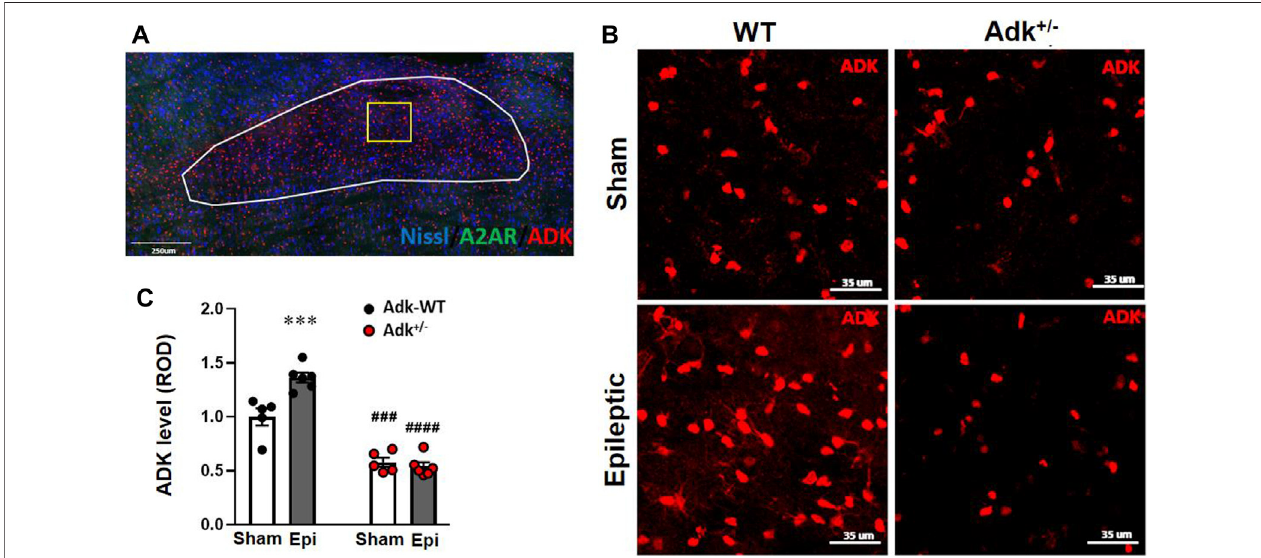
FIGURE 2 | ADK changes in the NTS of IHKA modeled epileptic mice. (A) Representative immuno fl uorescence (IF) image and an indication of selection of NTS region. (B) Representative images of IF staining for ADK in the NTS of IHKA modeled epileptic mice (Epileptic) vs. sham controls (Sham). (C) Quantitative analysis of the NTS expression levels of ADK (presented as relative optical density, ROD) in IHKA modeled epileptic (Epi) mice vs. sham controls (Sham). Data are mean ± SEM. *** p < 0.001 vs. sham controls of same genotype; ### p < 0.001 vs. WT sham controls; #### p < 0.0001 vs. WT epileptics; unpaired t -test. Scale bar = 35 μ